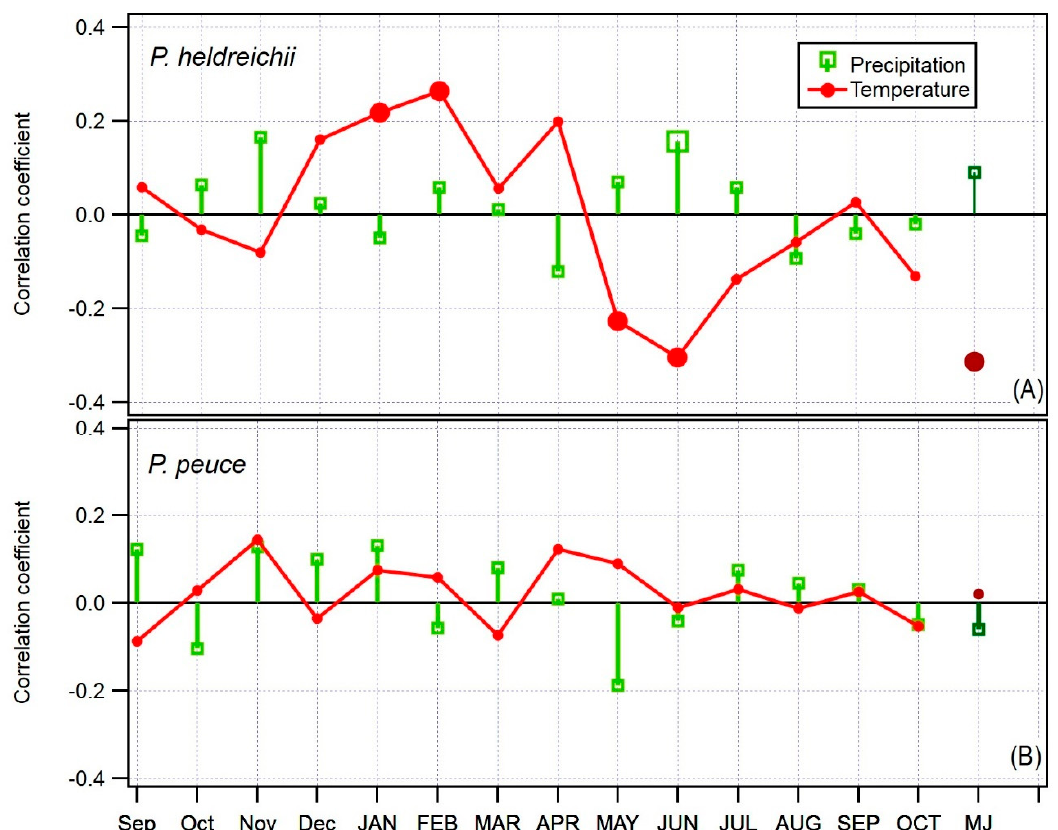
Figure 4. Bootstrapped correlation between TRW and average monthly temperature and sum of precipitation for the period 1901–2013, from September prior to ring formation until October of the year of ring formation. The response in May–June (MJ) is presented at the right side of the graph (for P. heldreichii only). ( A ) response of Pinus heldreichii TRW to climate. ( B ) response of Pinus peuce TRW to climate. Significant correlations ( p < 0.05) are indicated with larger markers. Table 4. Measurement of the prediction skill of the linear model for temperature reconstruction using Pinus heldreichii tree-ring widths for two periods, 1902–1957 (verification) and 1958–2013 (calibration): squared correlation coe ffi cient for the entire period of available climate data (r 2 ), reduction of